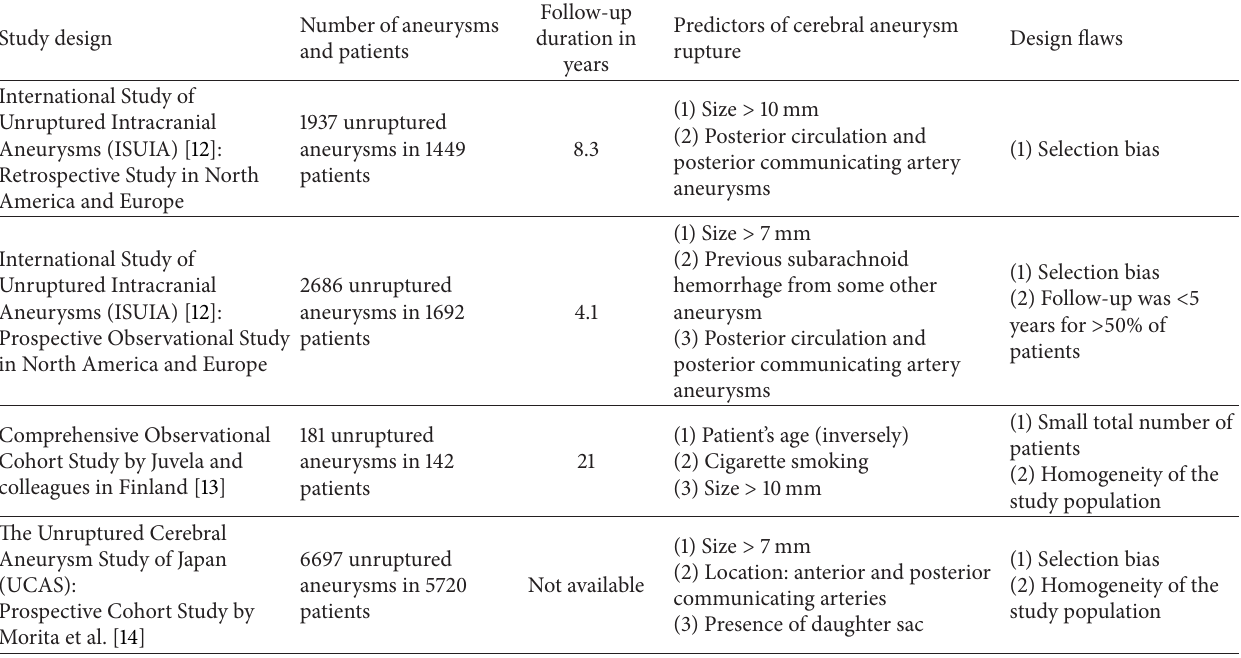
Table 2: Summary of large studies evaluating the natural history of unruptured cerebral